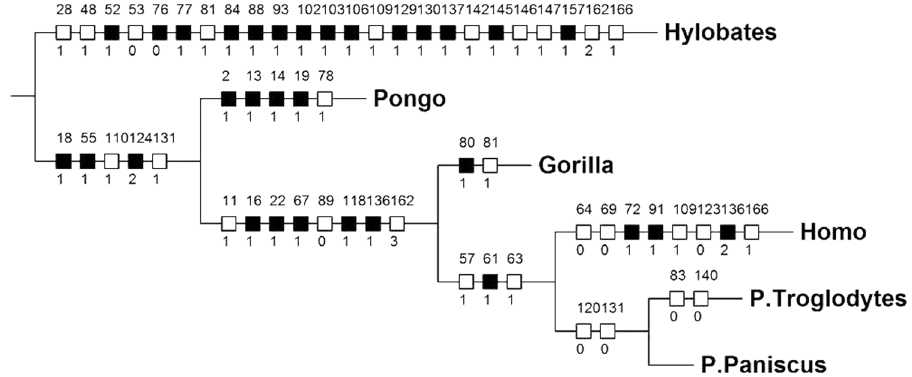
Figure 4. Cladogram showing evolutionary changes in head-forelimb musculature in hominoids. Single most parsimonious tree (L = 303, CI = 57, RI = 75) obtained in our phylogenetic analysis; for a key of the characters and character state changes show in the cladogram, see text and SI. Note how node leading to LCA of two Pan species has only two changes; P . troglodytes then accumulated two changes, with no changes in the bonobo lineage (for more details, see text). Note that the phylogenetic software converts P. paniscus and P. troglodytes into P. Paniscus and P.